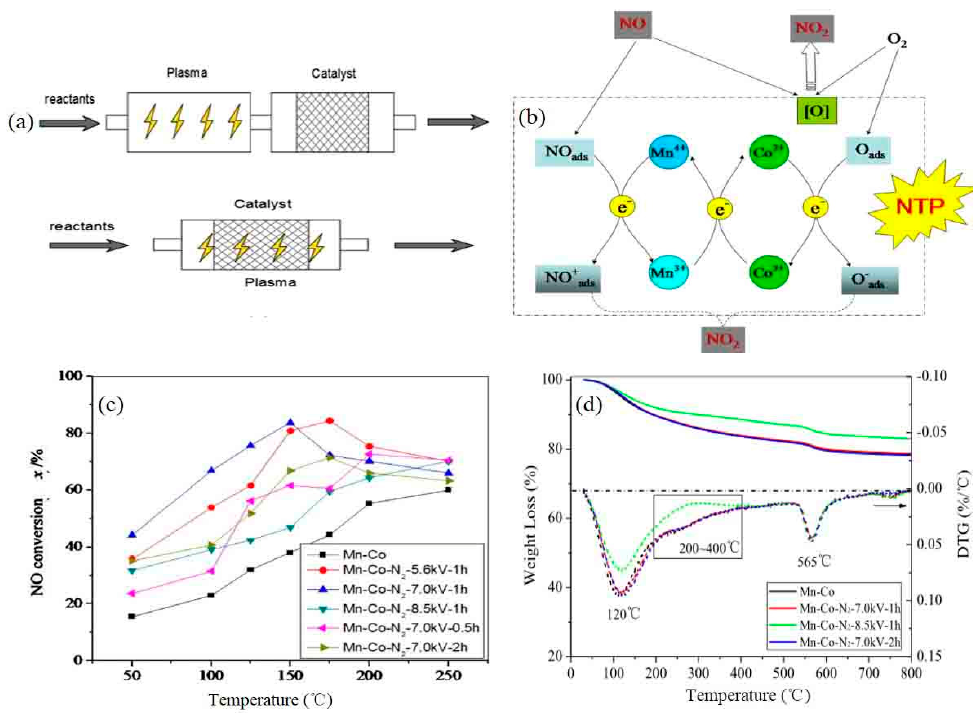
Figure 17. ( a ) Schematic diagram of plasma-enhanced catalysis and plasma-driven catalysis, ( b ) mechanism of low-temperature denitrification of nonthermal plasma-enhanced Mn-CoOx catalyst, ( c ) effect of plasma voltage and treatment time on NO conversion, and ( d ) study on thermal stability of thermogravimetric curves [255]. Reproduced from Ref. [255], Copyright 2015, Elsevier.